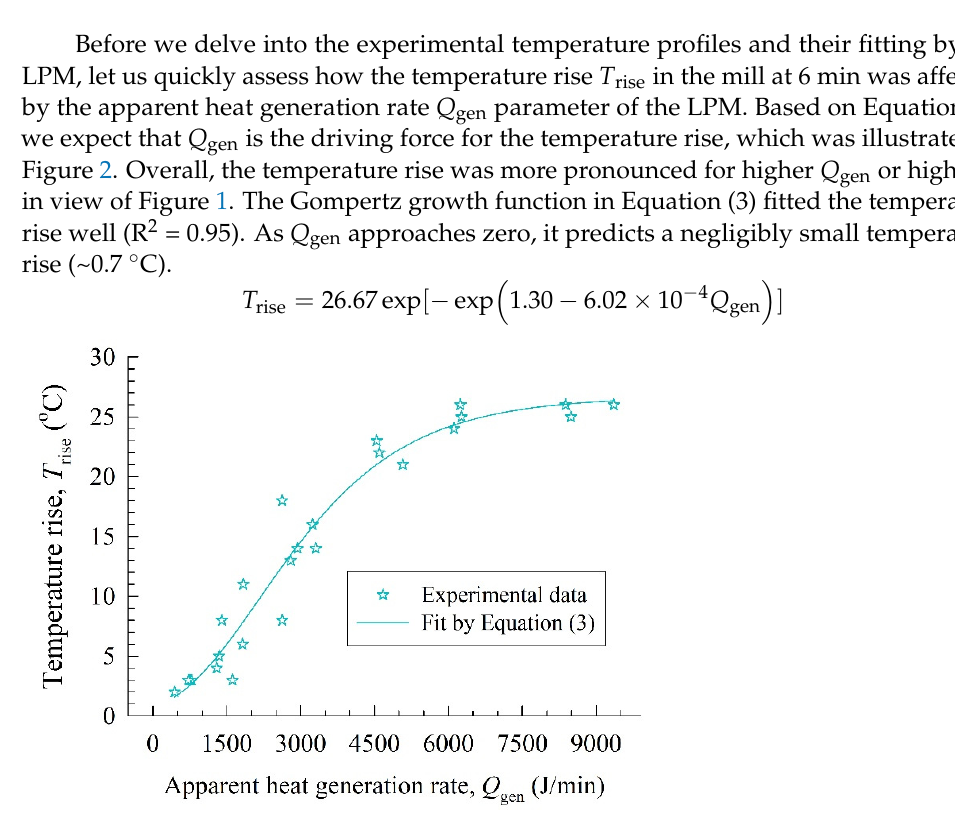
Figure 2. Temperature rise at 6 min as a function of the apparent heat generation rate (Runs 1–25).